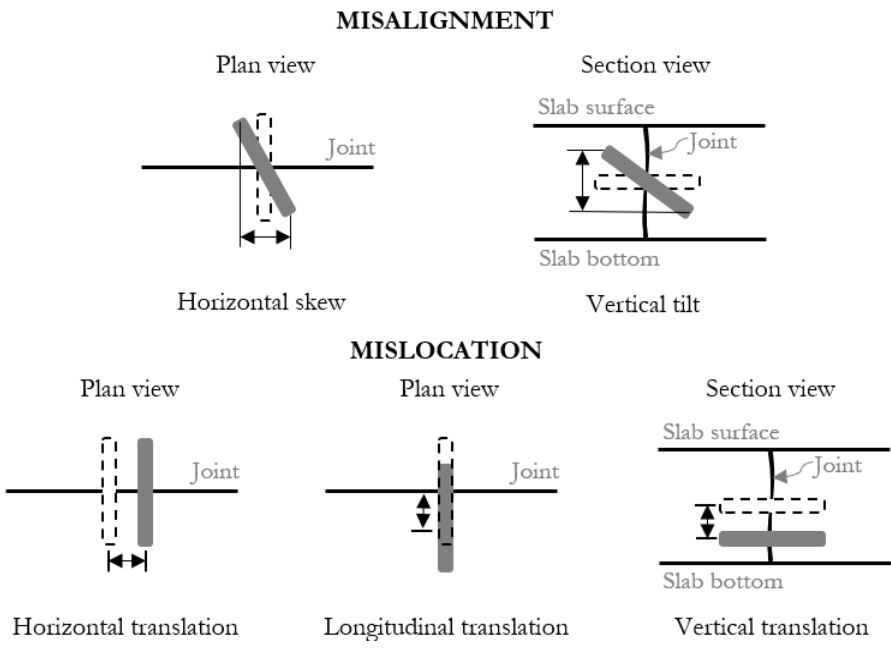
Figure 1. Main misalignment and misallocation types in dowel bars (Source: Adapted from Tayabji [3]).